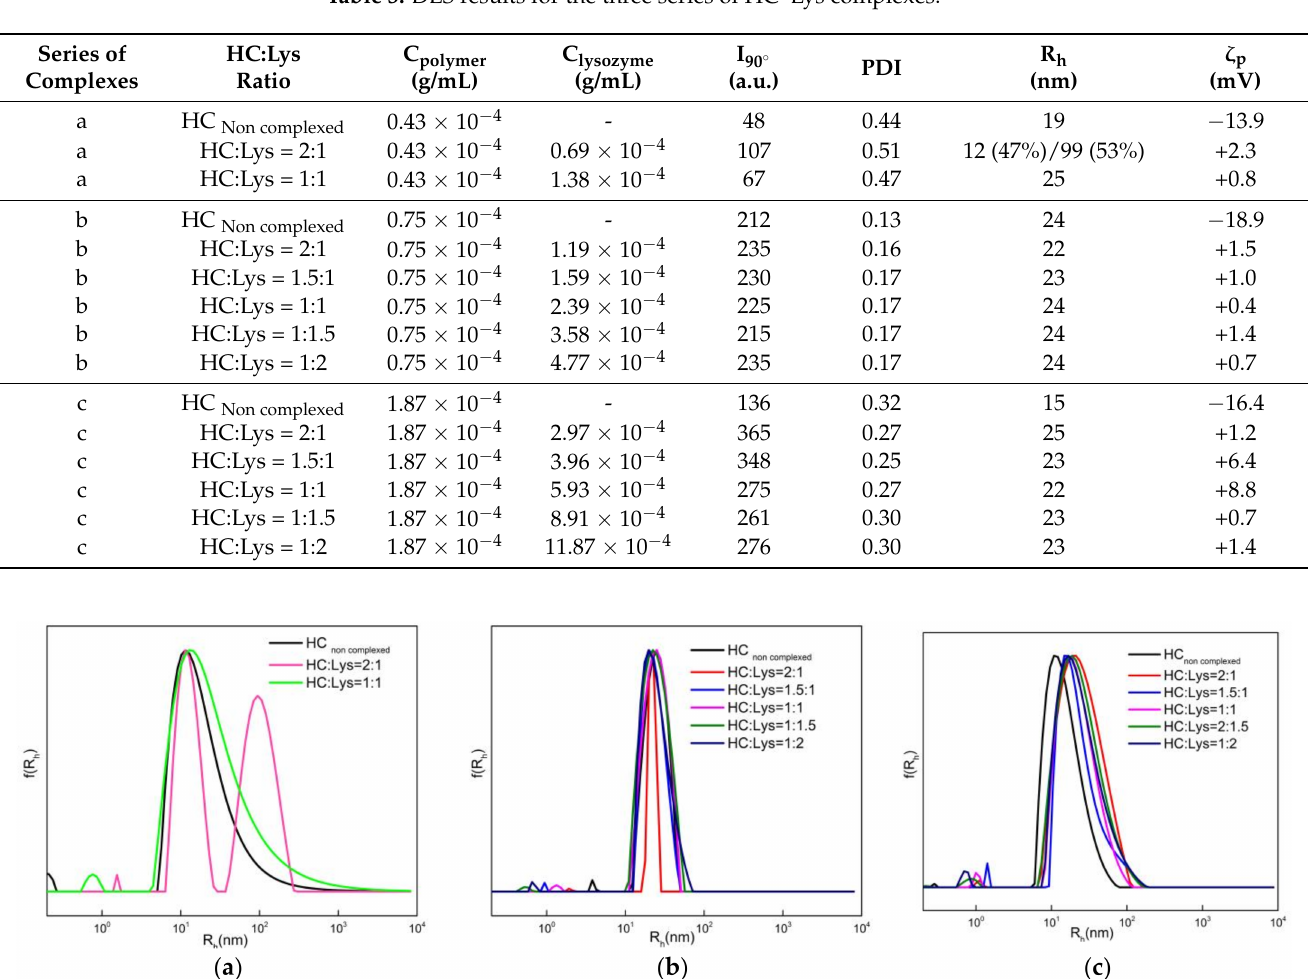
Table 3. DLS results for the three series of HC–Lys complexes.